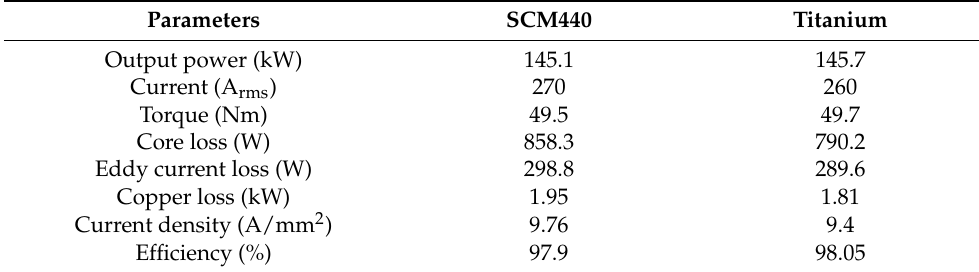
Table 3. Characteristic results at load according to shaft